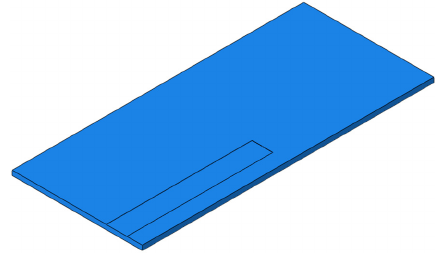
Figure 20. The RP of SCC. The comparison of the main dynamic response time history curves of each structural layer in the conditions of RP and NP is shown in Figure 21. Compared with the condition of NP, in the condition of RP, the parting area increases the overall vibration response of the track structure due to the weakening of support strength and structural constraints. The wheel–rail vertical force is increased by 10.5%. The wheel–rail force obviously in- creases on the parting side due to the damage of the structure under the rail. For the rail, the vertical speed of the rail is almost unchanged; the rail displacement increases, with an increase of 12.5%; and the rail acceleration increases most significantly, with an increase of 50.4%. The rail vibration increases significantly when the rail is separated from the joint under the rail. The speed of the track slab and SCC layer changes little, the displacement increases slightly, and the acceleration and vertical stress change significantly. Accelera- tion increases of track slab and SCC layer are 87.5% and 39.1%, respectively. As the parting develops to the rail–falling axle interface, the longitudinal stress of the SCC layer de- creases by 22.2%, the vertical stress increases by 81.8%, and the dynamic response of the SCC layer changes sharply. For the base and subgrade bed, due to the damping effect of the isolation layer, the changes of acceleration and vertical stress are relatively weakened, the acceleration of the base increases by 32.7%, and the dynamic response of the surface layer of the subgrade bed has little change.